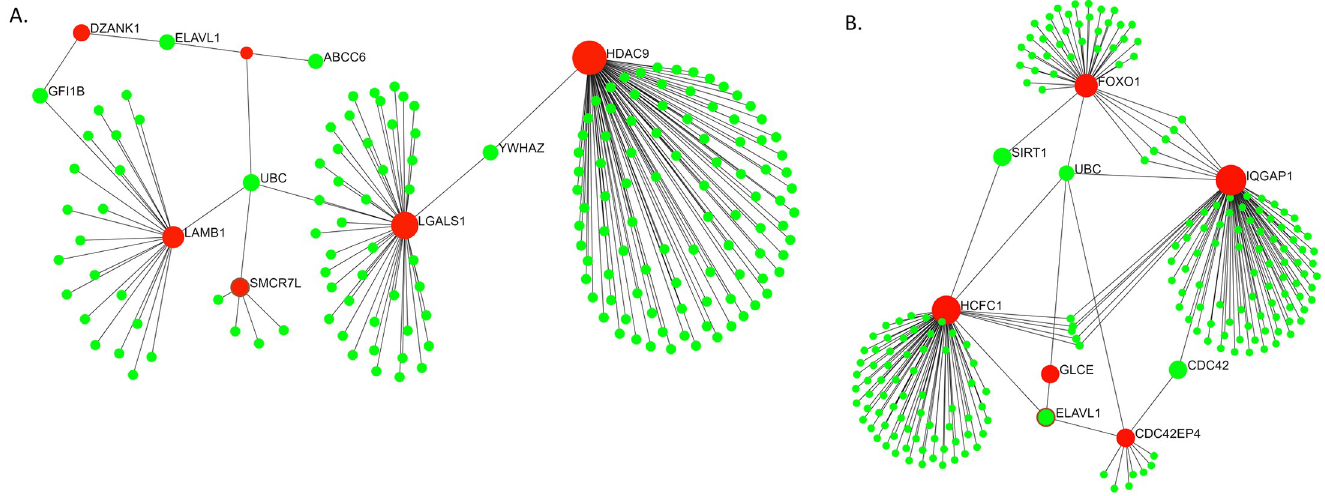
Fig 8. Roles of MGS selected top genes in pathways related to cancer. (A) LGALS 1 and LAMB 1 were selected among the top 10 genes from GDS3341 dataset by the MGS rf . These (highlighted in red) are part of a sub-network that contains many other proteins (highlighted in green) known to play roles in different cancers [44]. (B) HCFC 1, FOXO 1 and IQGAP 1 were selected among the top 10 genes from GDS4824 dataset by the MGS rf . These (highlighted in red) are part of a sub-network that contains many other proteins (highlighted in green) known to play roles in different cancers